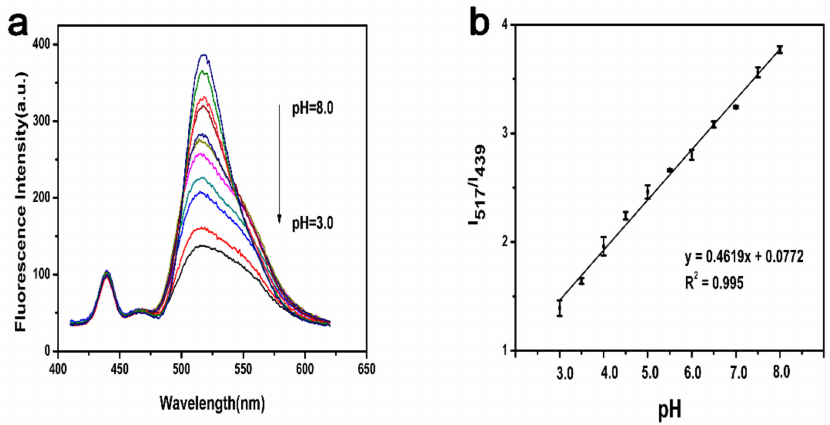
Figure 4. ( a ) Fluorescence emission spectra of Pdots-PPF at pH 3.0–8.0 in 20.0 mM HEPES bu ff er solution when excited at 380 nm. ( b ) Plot of the relative fluorescence intensity ratios (I 517 / I 439 ) of Pdots-PPF in response to pH